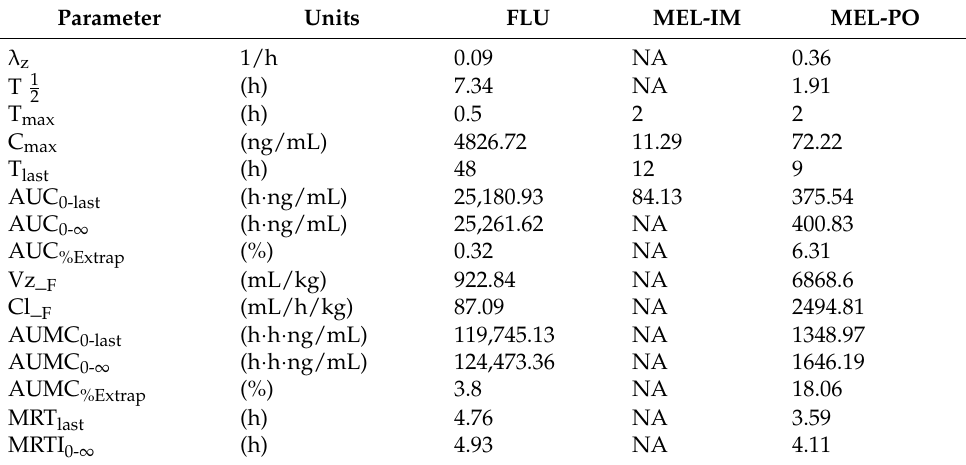
Table 3. Pharmacokinetic parameters in plasma after administration of a single dose of flunixin (2.2 mg/kg) intramuscularly or meloxicam (1 mg/kg) intramuscularly or orally (n = 6) in tilapia. Parameter